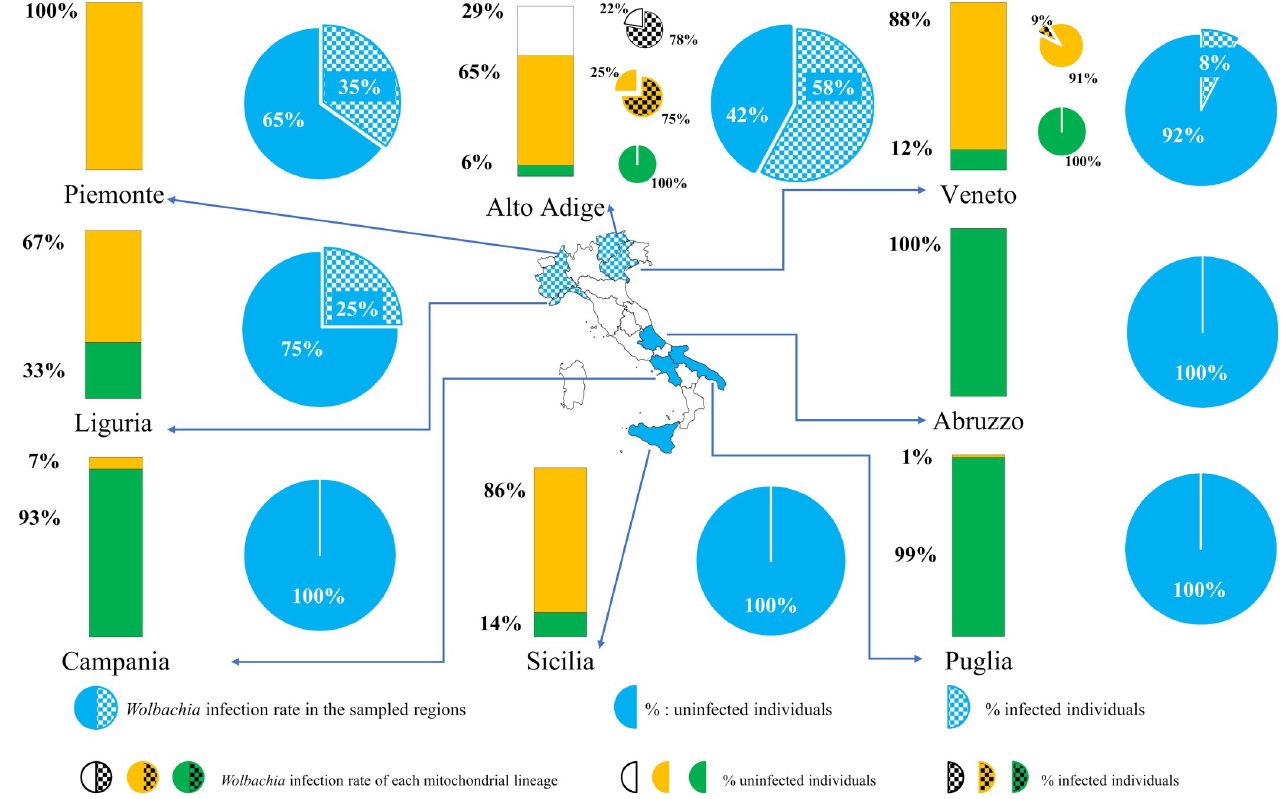
Fig 2. Frequency of mitochondrial lineages of Philaenus spumarius (histograms) and Wolbachia infection rate (cakes) in the sampled regions of Italy. The percentage of infected individuals is the slice of cake colored with checkered texture. Similarly, regions with populations of P . spumarius infected by Wolbachia are colored with checkered texture on the map. The blue big cakes represent the Wolbachia infection rate calculated on the total number of individuals sampled in each region. The small cakes represent the Wolbachia infection rate calculated on the individuals of each mitochondrial lineage. The map of Italy by Sinigagl (https://commons.wikimedia.org/wiki/File:Italy_template_blank.png) is licensed under CC BY-SA 3.0; it is similar but not identical (it differs for the colored regions) to the original map and is therefore for illustrative purposes only.